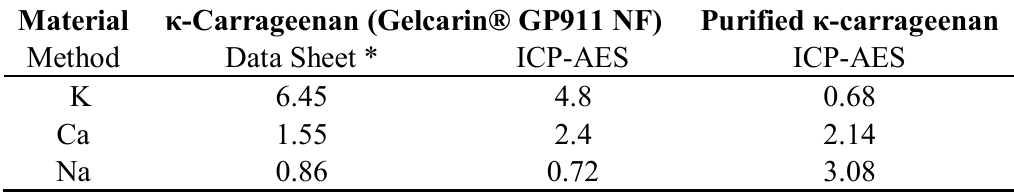
Table 1. Cation content of the commercial and purified κ-carrageenan samples, expressed in wt